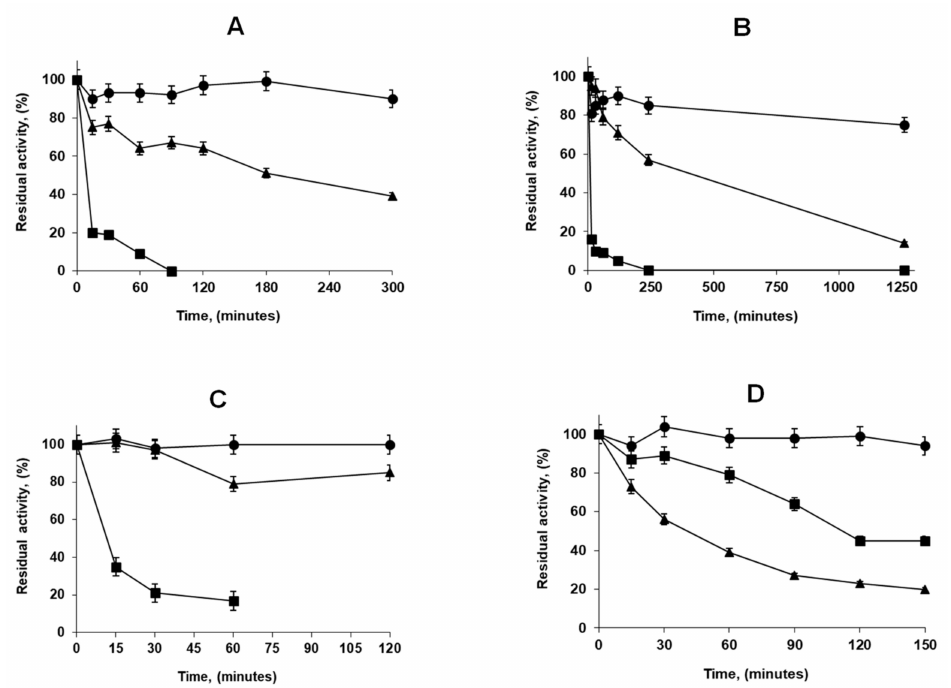
Figure 2. Inactivation profiles of di ff erent lipase biocatalysts incubated under di ff erent conditions. Other specifications are described in methods. 55 ◦ C, pH 7 ( A ); 55 ◦ C, pH 5 ( B ); 50 ◦ C, pH 5 ( C ); and 42 ◦ C, pH 9 ( D ). Solid circles: octyl-PFL; solid triangles: octyl-RML; and solid squares: